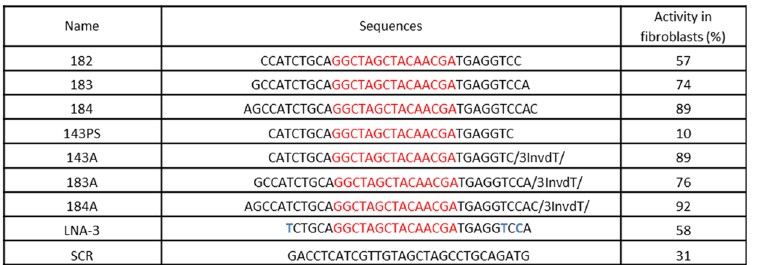
Figure 3. Second-generation DNAzymes derived from RNV143, targeting the ITGA4 mRNA. The activity of DNAzymes directly correlated with the percentage of ITGA4 mRNA knockdown. Activities of DNAzymes were calculated as described in Materials and Methods. The catalytic motifs are shown in red, the arm regions are in black and the residues modified with LNA are in blue. The sequences are from 5 ′ → 3 ′